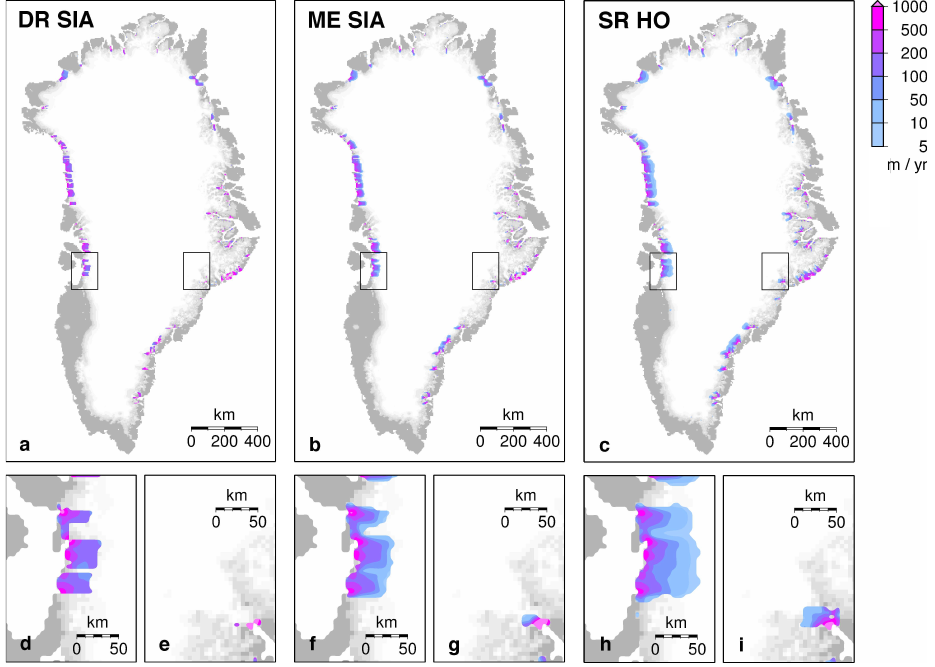
Fig. 4. Initial response in surface velocities to the MarAsl2 perturbation for the three main model versions. Initiated from the 5km IS, the geometry is still identical although the A sl forcing already operates. Shown are accelerations with respect to a control experiment run for each model version. In the DR SIA setup (a) , the marginal accelerations are inherently confined to the forcing area. The close-ups of Jakobshavn Isbræ (d) and Kangerlussauq (e) allow the clear identification of the grid cells that experience A sl amplification. In the ME SIA (b, f, g) and SR HO setup (c, h, i) , direct horizontal coupling is included and effects from both longitudinal stresses and transverse horizontal shearing are